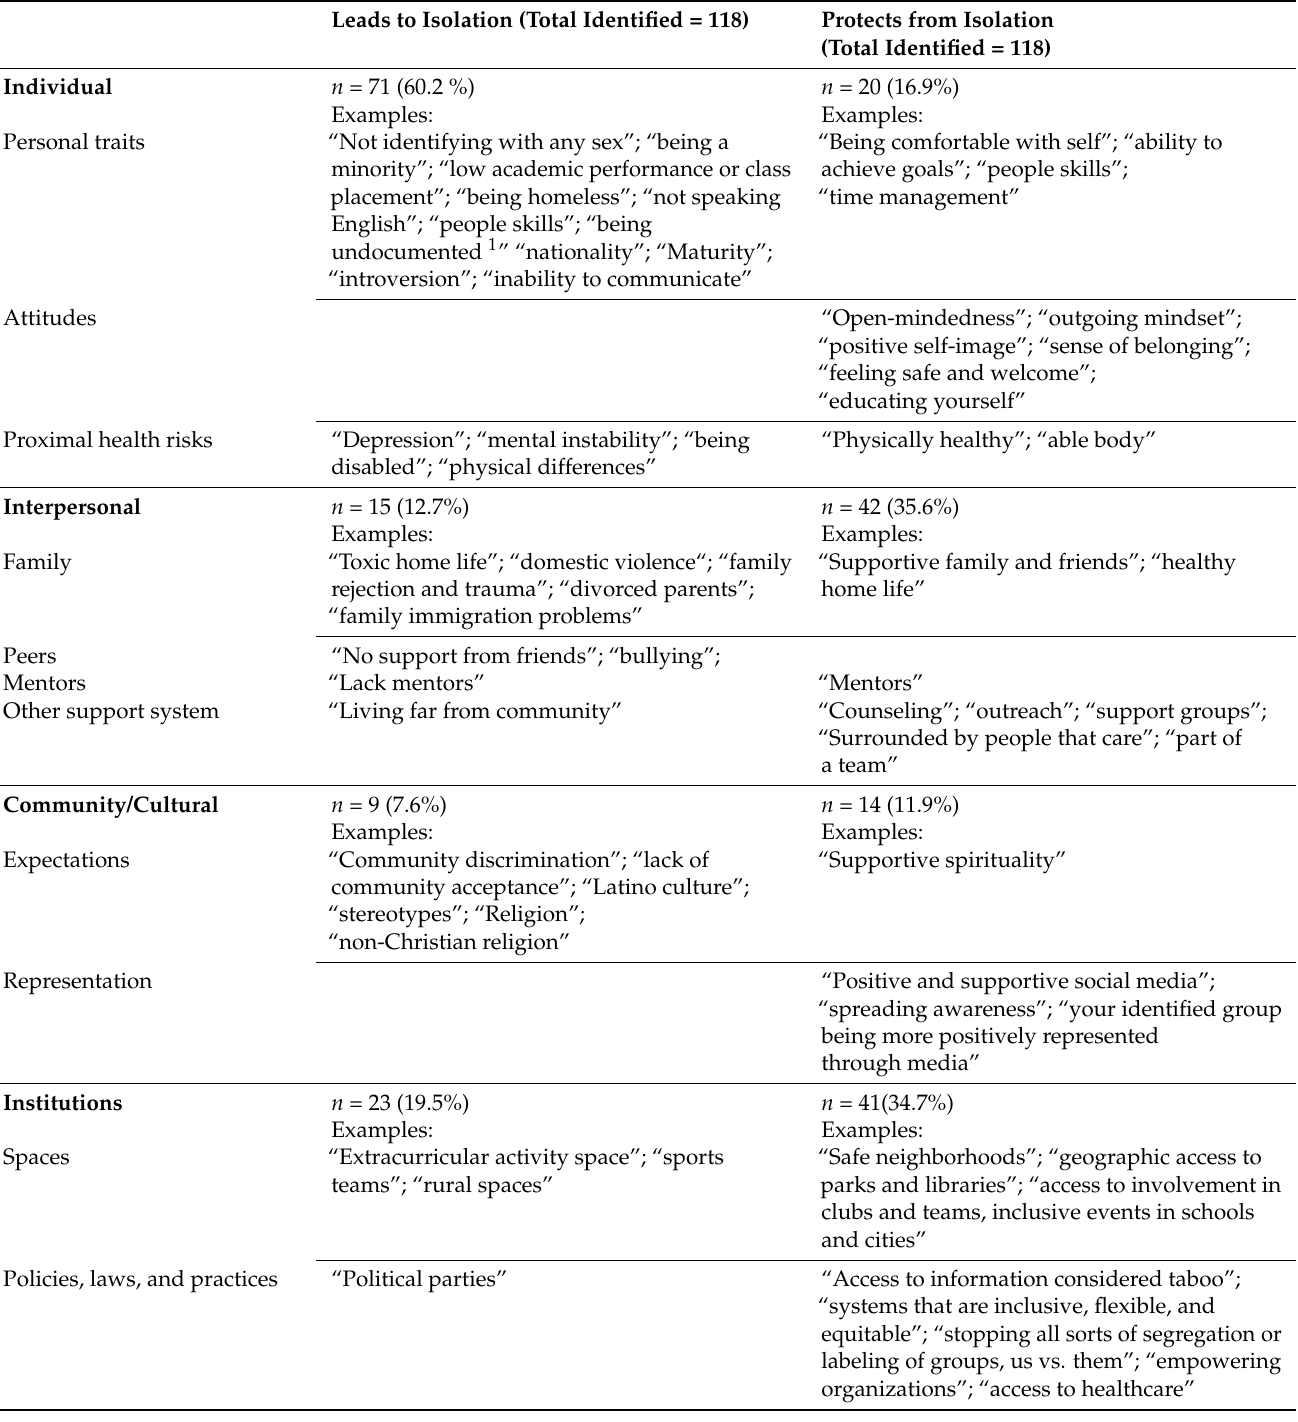
Table 3. Latinx 4-H youth’s Perspectives on Social